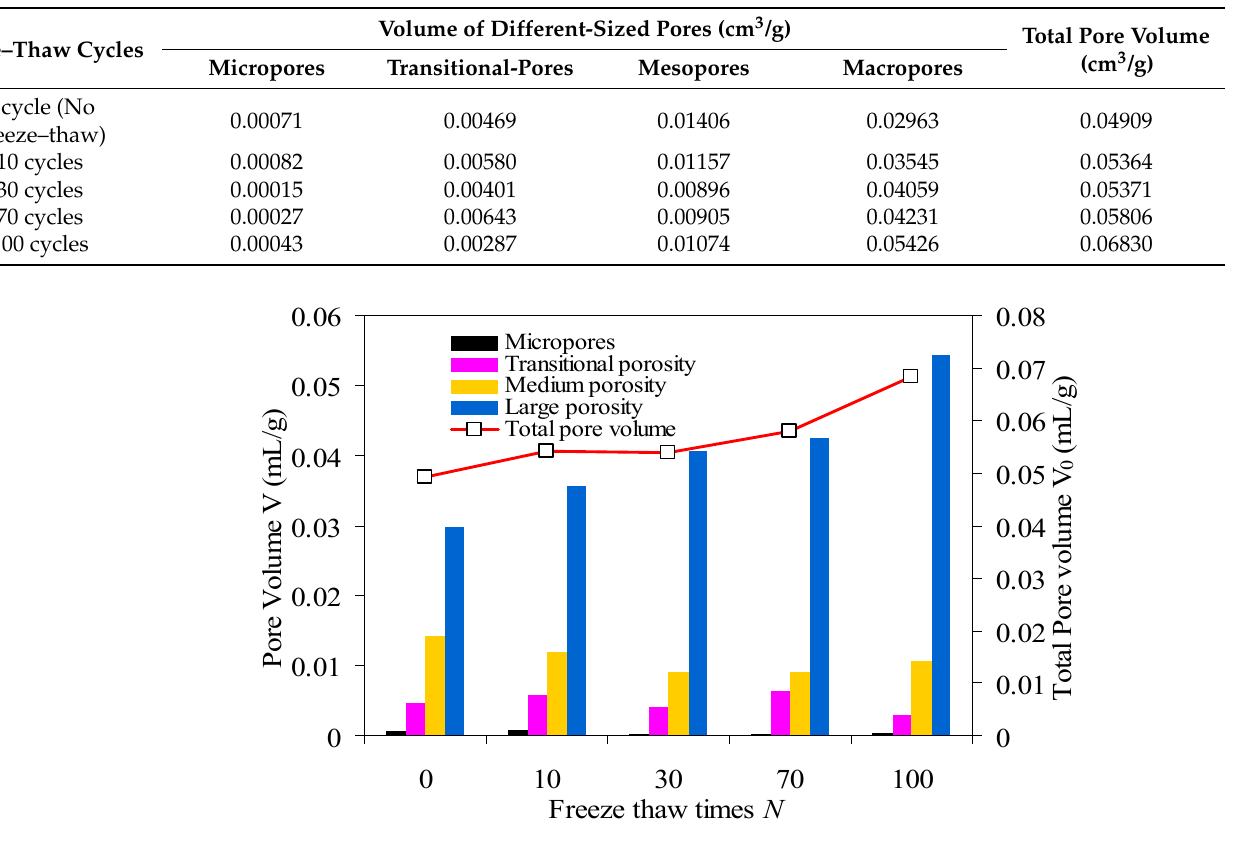
Figure 6. Pore volume distribution of red sandstone. Table 1. Pore volume parameters of red sandstone.